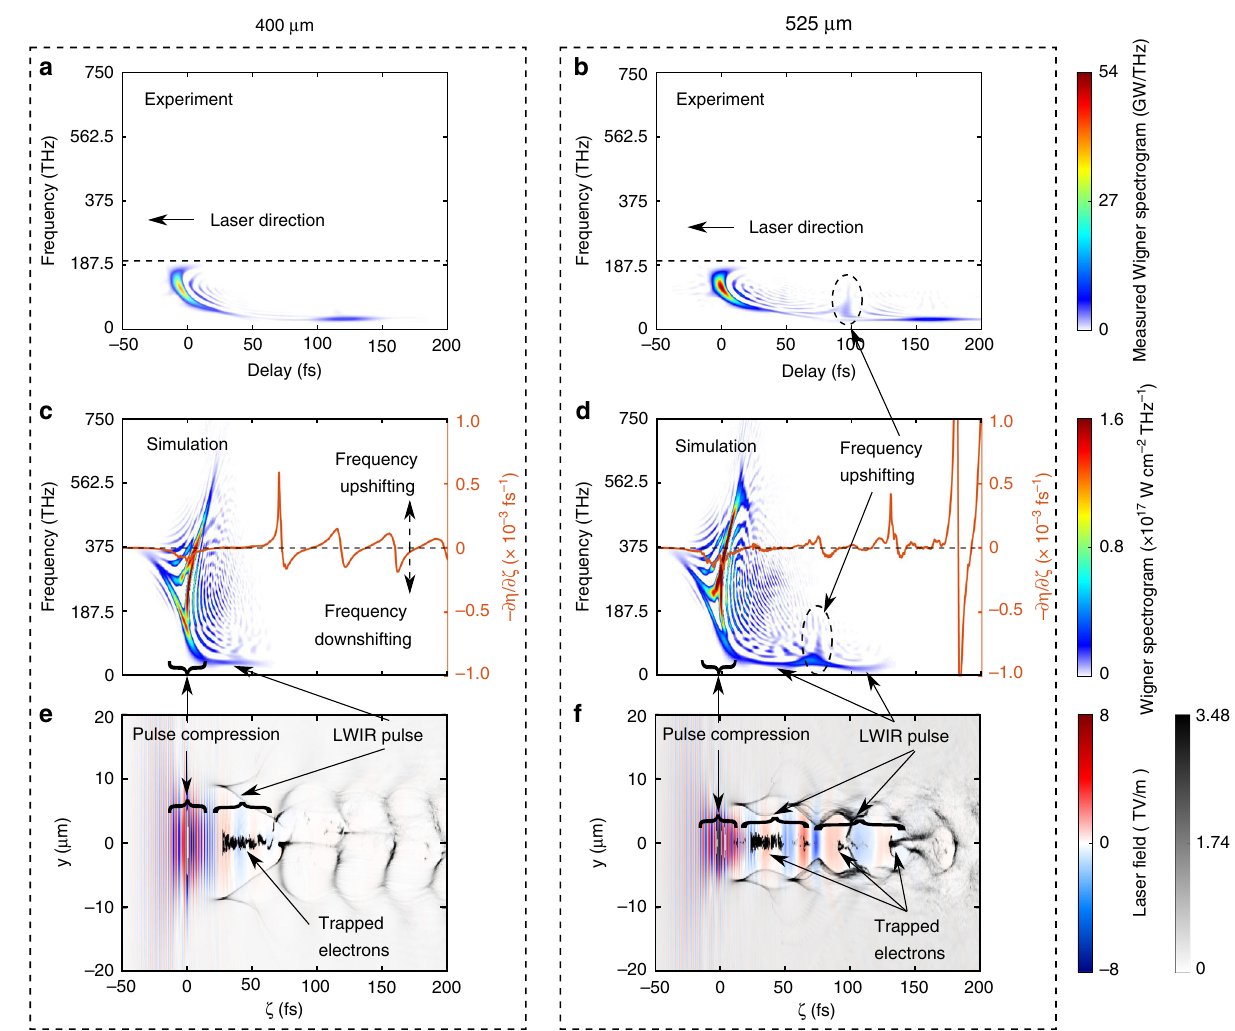
Fig. 4 Comparison of measured and simulated Wigner spectrograms of generated IR pulses. a , b Wigner spectrograms of measured IR pulses when the blade is at 400 and 525 μ m, respectively. The dashed lines represent the upper limit of the measurable IR frequency range due to the optics used to transport the LWIR radiation to the XFROG device. The IR components above 200 THz ( λ < 1.5 μ m) are fi ltered out to remove strong residual drive pulse. c , d Simulated Wigner spectrograms of one snapshot of the evolved on-axis laser fi eld and the negative refractive index gradient − ∂ η / ∂ ζ (orange line) in the plasma downramp (the OC section) for the cases in ( a ) and ( b ), respectively. The local frequency of the photons is downshifted (upshifted) when this negative gradient is negative (positive). e , f The corresponding snapshot of plasma density (wake) and the laser electric fi eld for the cases in ( c ) and ( d ), respectively. Strong photon frequency down-shifting occurs at the front of the self-compressed pulse generating a LWIR pulse that recedes by GVD into the fi rst wake cavity ( c ) and partially leaks into the second wake cavity in the case of ( d the IR-CON and OC sections are non-axisymmetric and thus they cannot be retrieved by the Abel inversion method. In the of fl ine measurement, hydrogen is